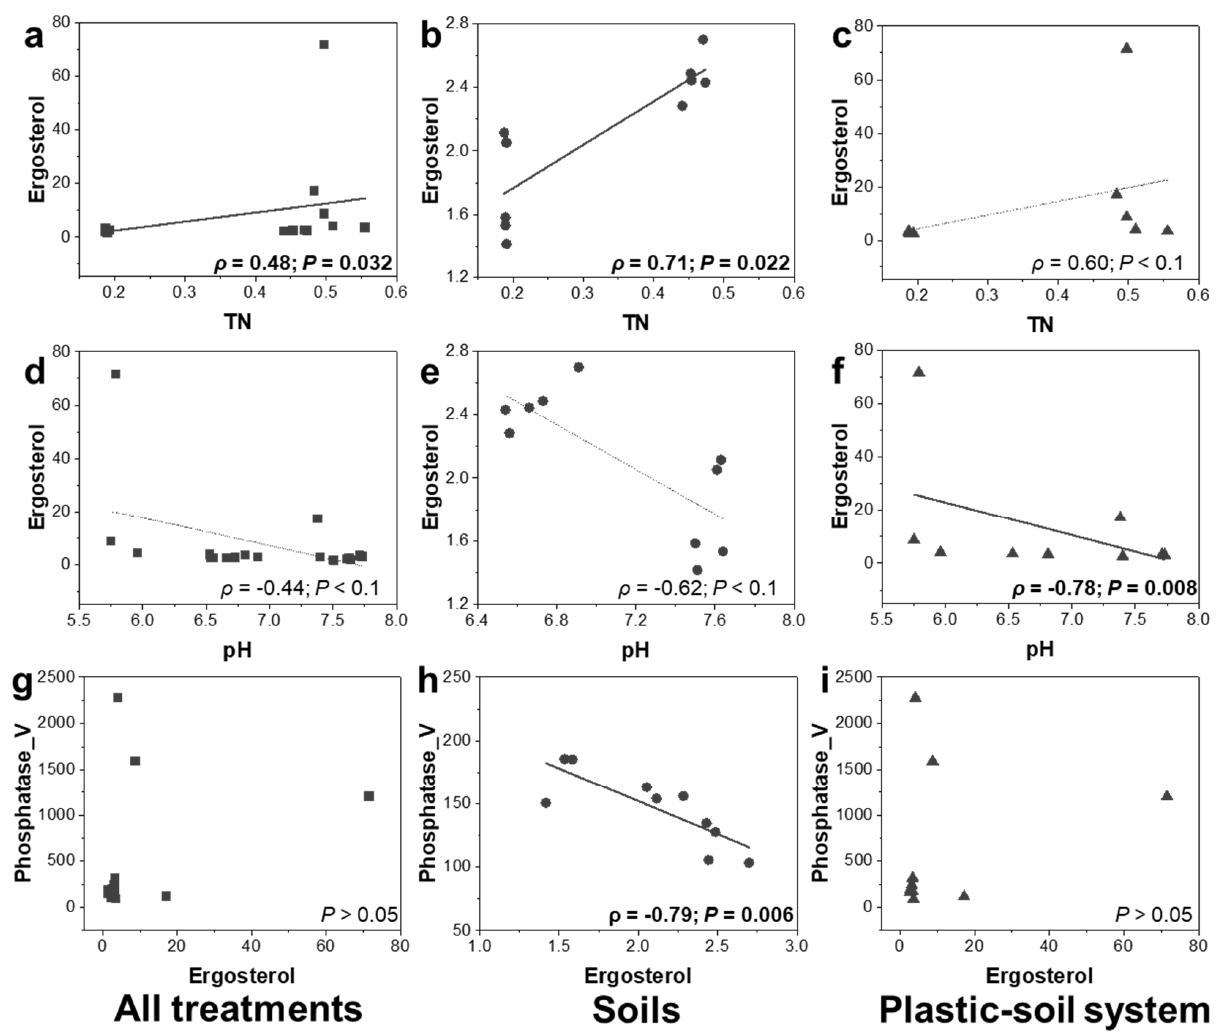
Figure 6. Correlations between total nitrogen (TN) ( a – c ), pH ( d – f ), maximum rate of reaction (Vmax) of phosphatase (Phosphatase_V) ( g – i ), and ergosterol content in soils of all treatments (left panel, ( a , d , g )), control S and control SN treatments (middle panel, ( b , e , h )), and PS and PSN treatments (right panel, ( c , f , i )). Spearman’s rank correlation was performed for aforementioned comparisons. The squares, circles and triangles indicate data points from combination of all treatments, soil without PBSA addition and PBSA added soil respectively. The correlation table for all comparisons is provided in Supplementary Table S1a–c. Statistical significance is given in bold. Thin line indicates marginally significant correlation.